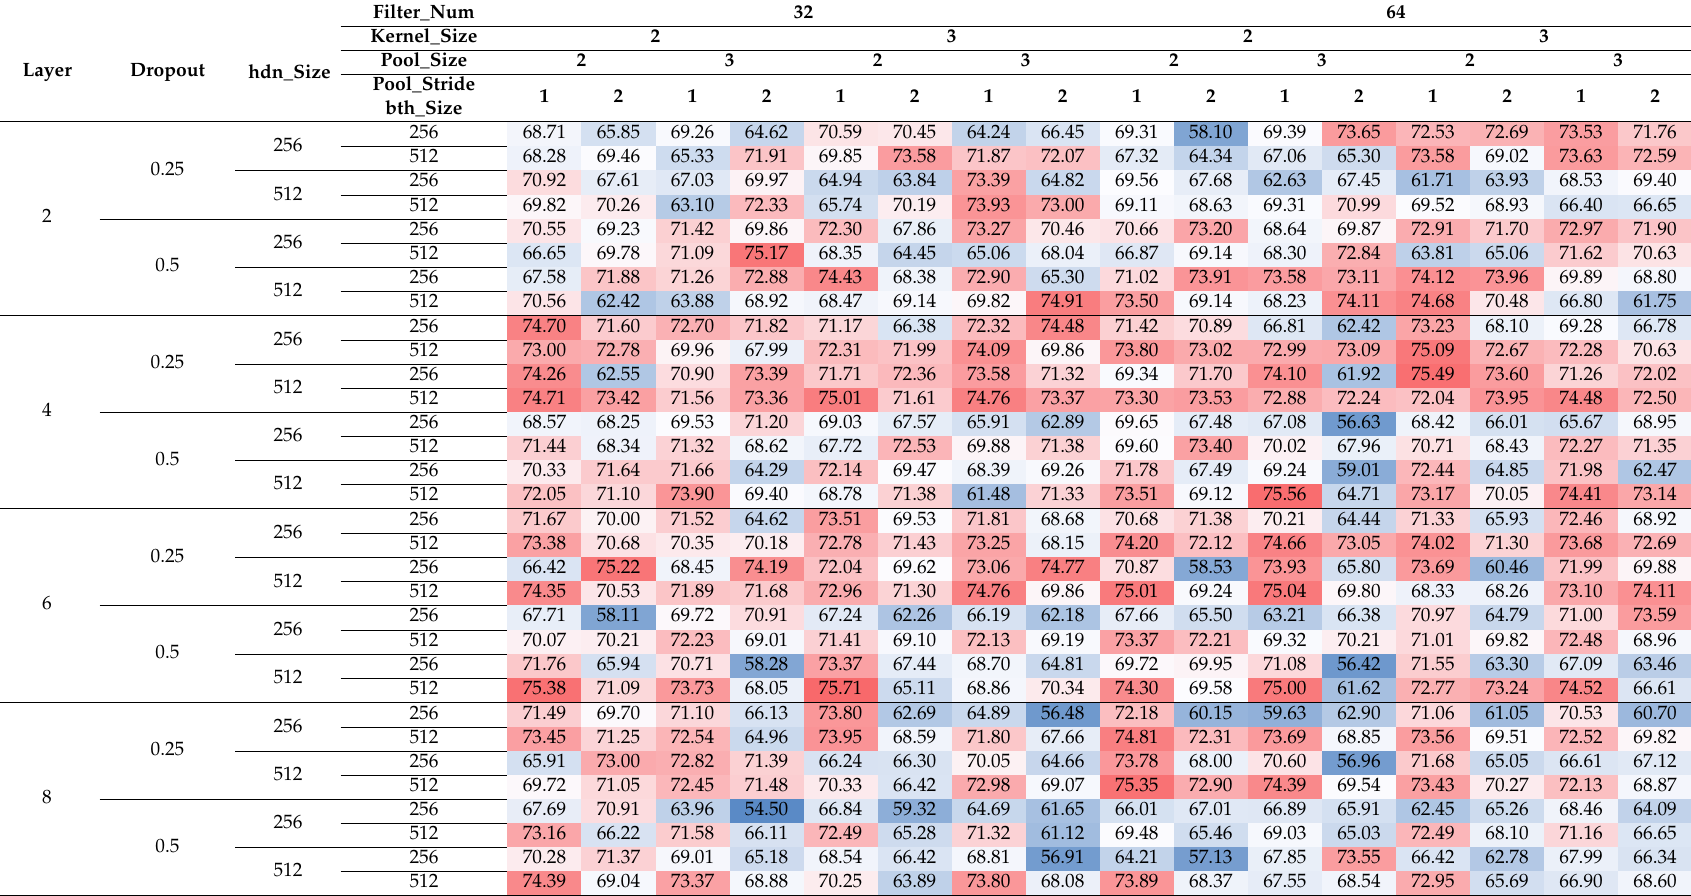
Table A1. Comparison of performance by parameters. The explanation on this table is in the